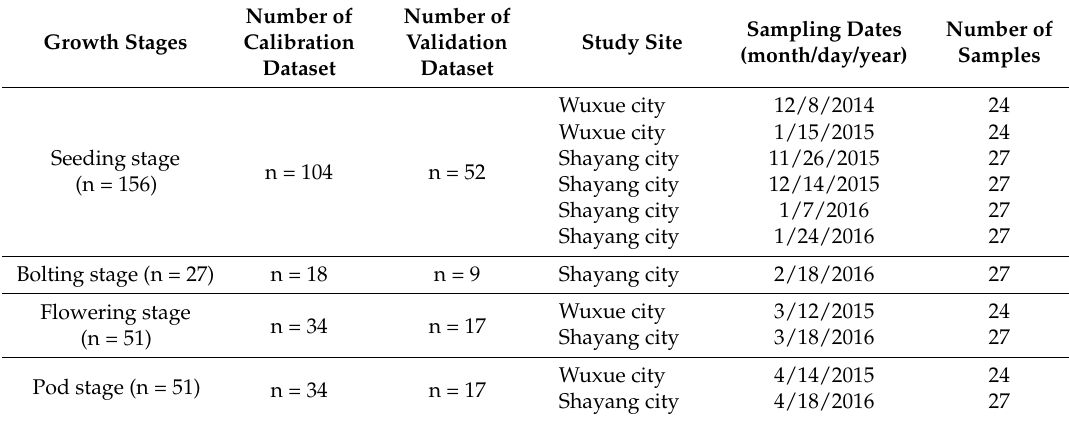
Table 2. Number of calibration and validation dataset at different growth stages.